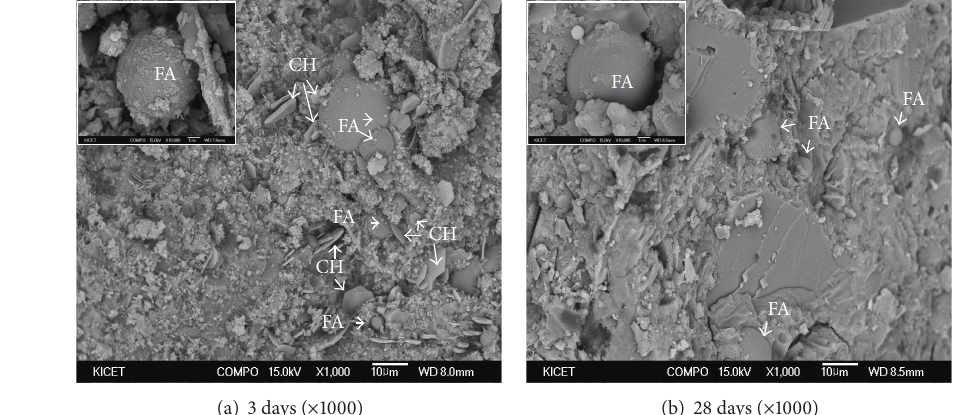
Figure 4: The SEM of high volume fly ash HFC.